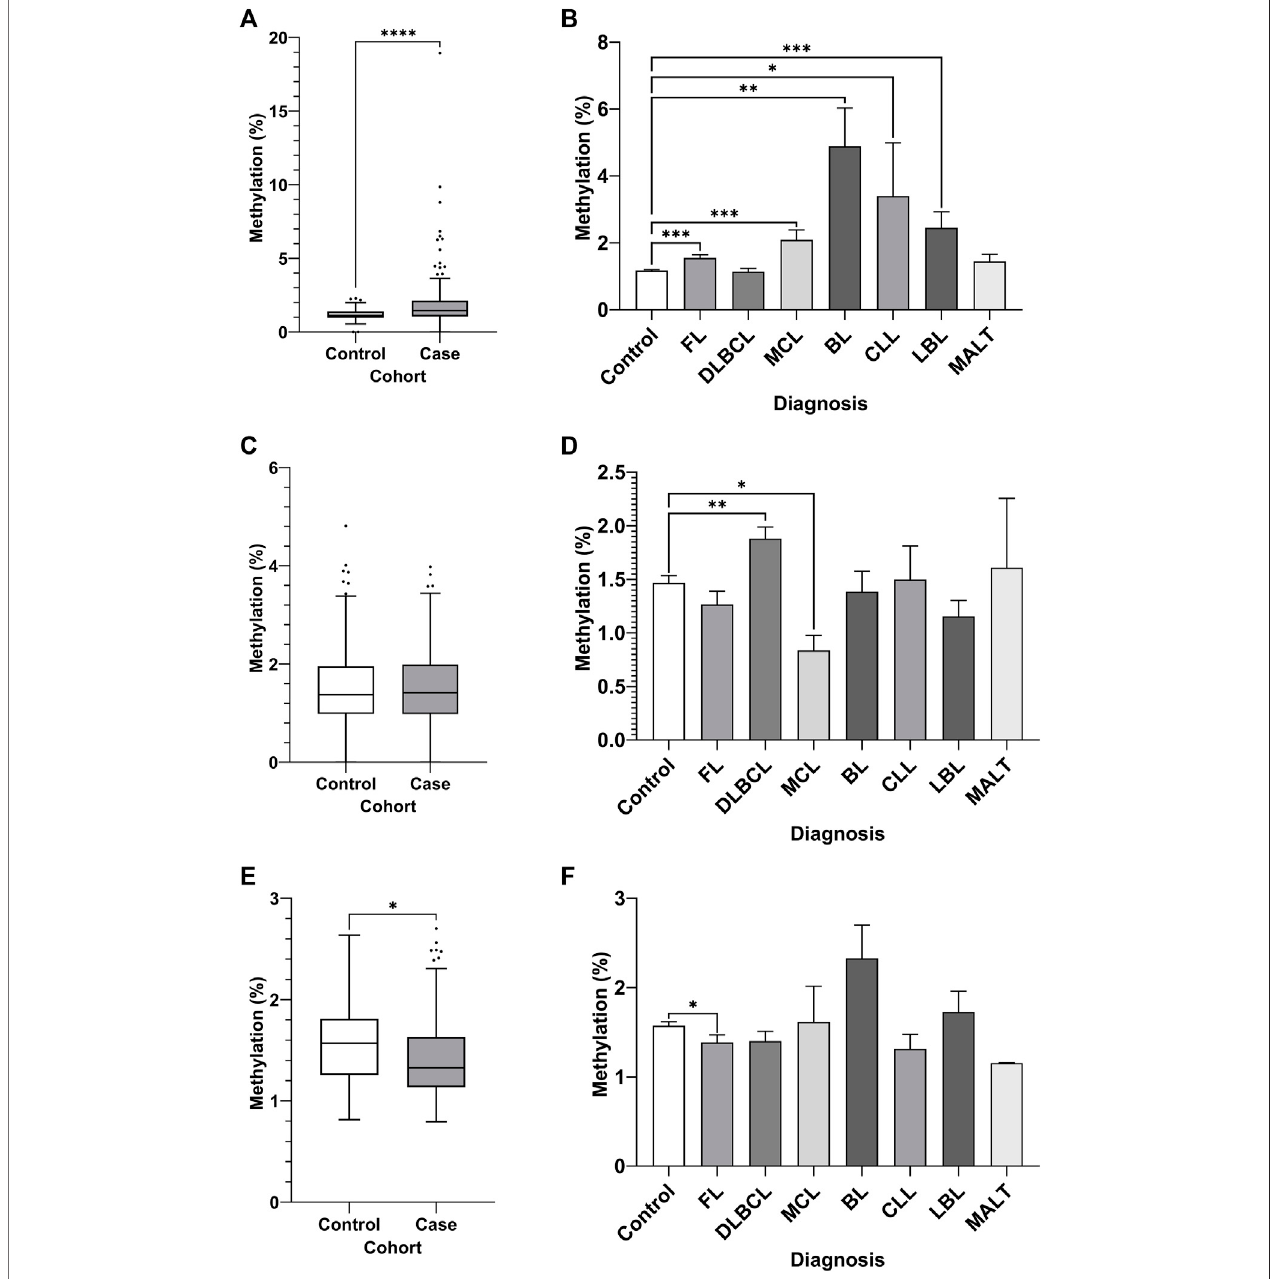
FIGURE4| Promoter DNAmethylationofCpGsintworegionsofthepromoterCGIofthemiR-17 ∼ 92clusterandoneregioninthepromoterCGIoftheTET2gene inwholebloodgDNAofaretrospectiveNHLcase-controlcohort.Bisul fi tepyrosequencingwasperformedontworegionsinthepromoterCGIsofthemiR-17 – 92cluster and in one region of the TET2 gene. Mean methylation levels of 4 CpGs in the two regions, 532 bp (A – B) and 774 bp (C – D) upstream of the MIR17HG TSS were assayed, and mean methylation levels of 6 CpGs in the fi rst exon of TET2 were also assayed (E – F) . Patients were categorised by NHL subtype, with mean methylation levels compared between subtype and controls. Individuals without a speci fi c subtype were not included in comparison between diagnosis. Bars denote mean and error bars denote SEM. Statistical signi fi cance calculated by KW test of signi fi cance and a post-hoc Dunn test for comparison of cell lines to controls, with signi fi cance denoted as: **** p < 0.0001, *** p < 0.001, ** p < 0.01, * p < 0.05.